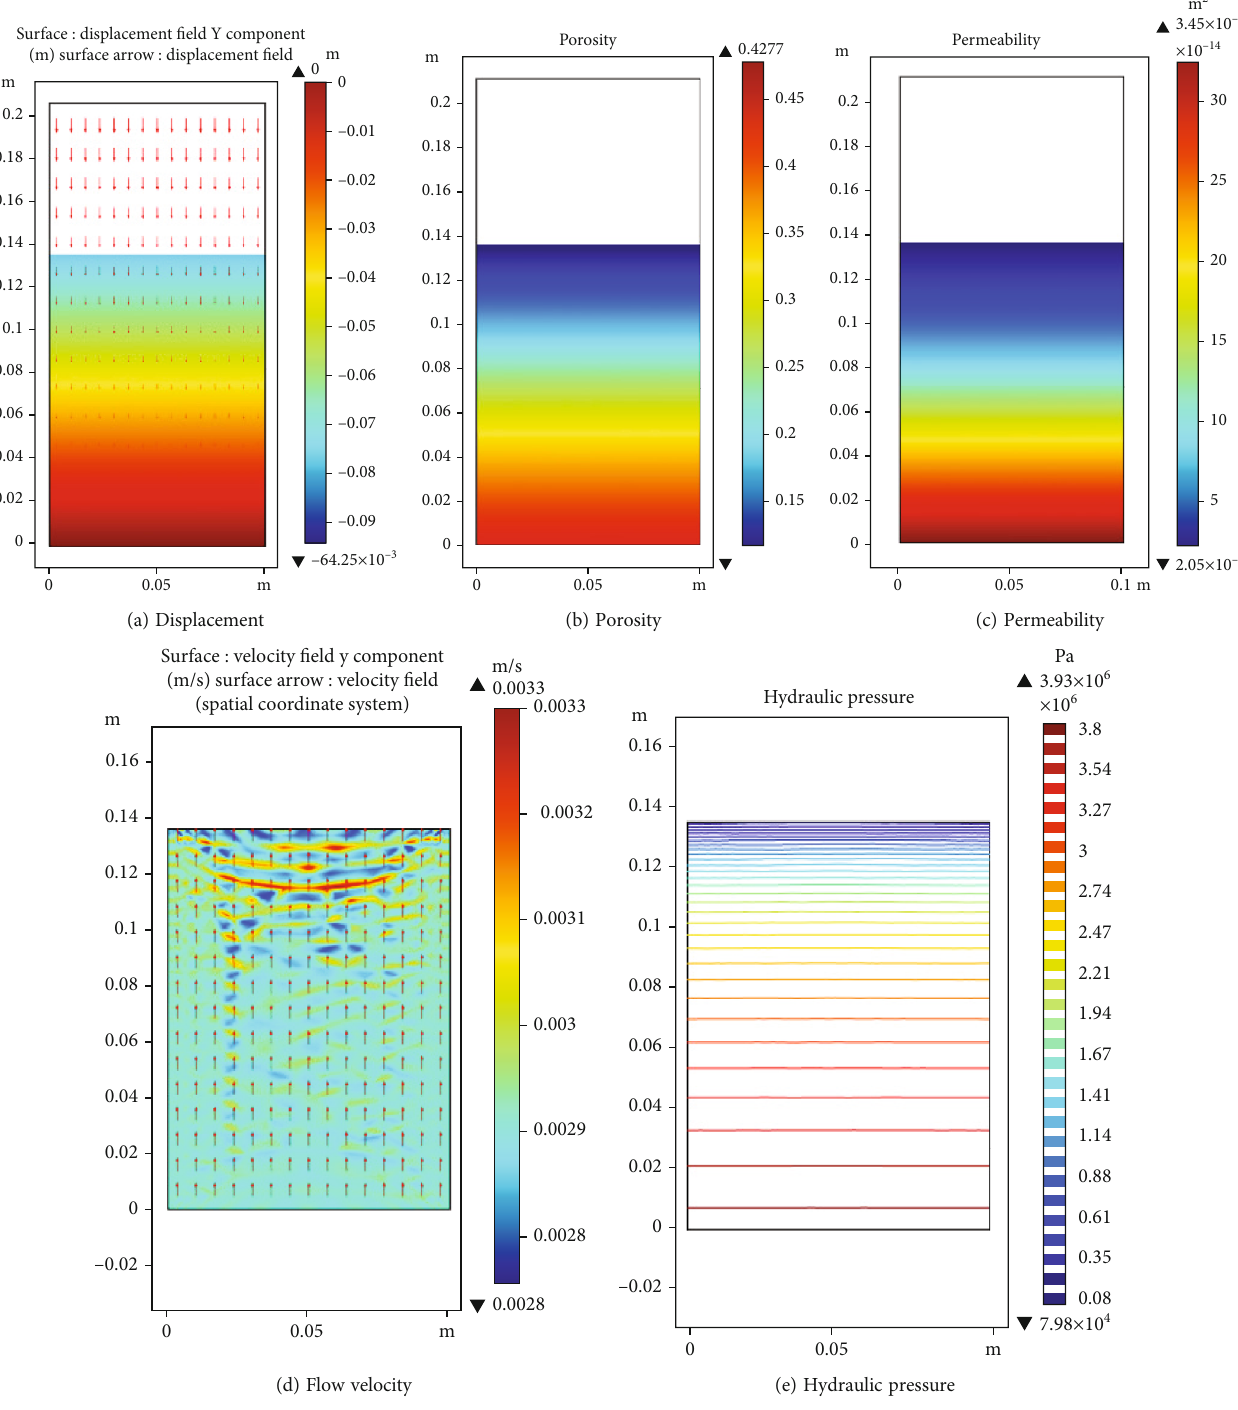
Figure 14: Seepage rules in the gangues with a size range of 15 ~